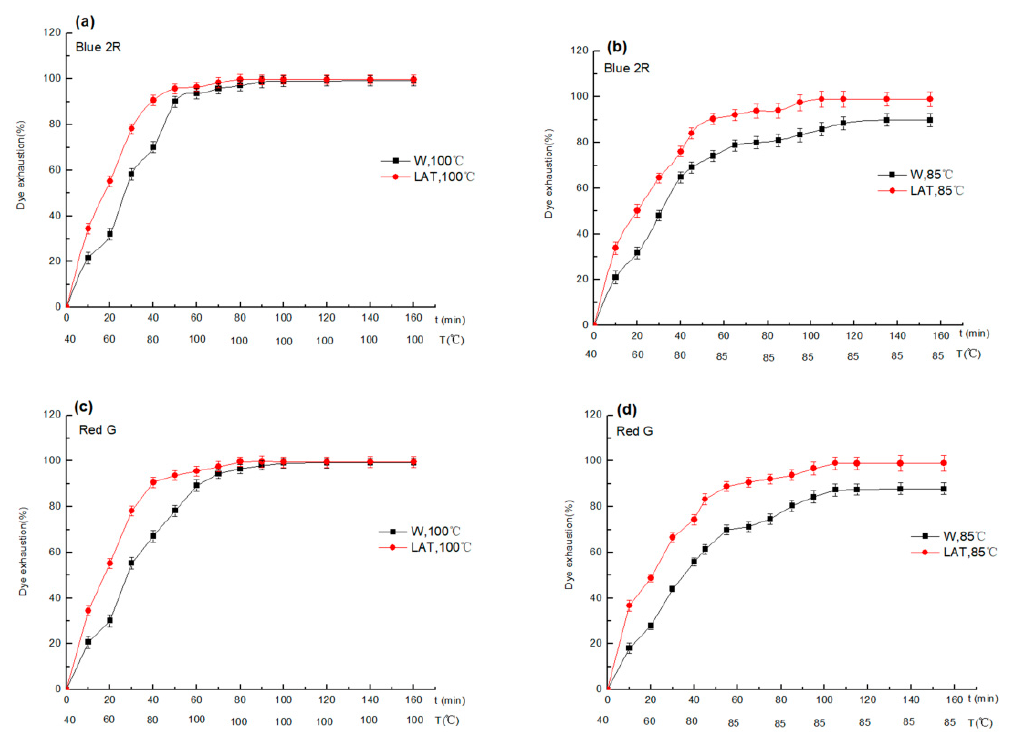
Figure 6. Dyeing rate of W and LAT dyed with Lanaset dyes at different temperatures: ( a ) Blue 2R-100 °C; ( b ) Blue 2R-85 °C; ( c ) Red G-100 °C; and ( d ) Red G-85 °C.